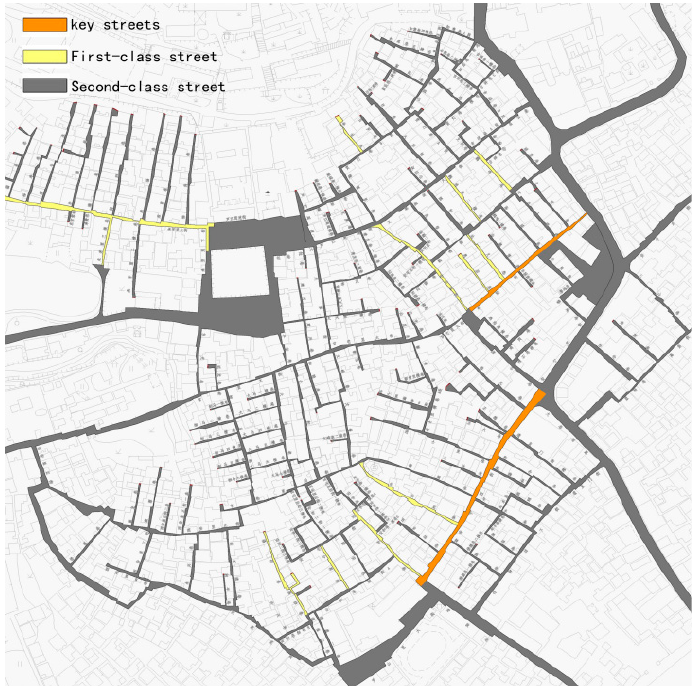
Figure 4. Pattern and texture of Shawan Ancient Town. (Source: